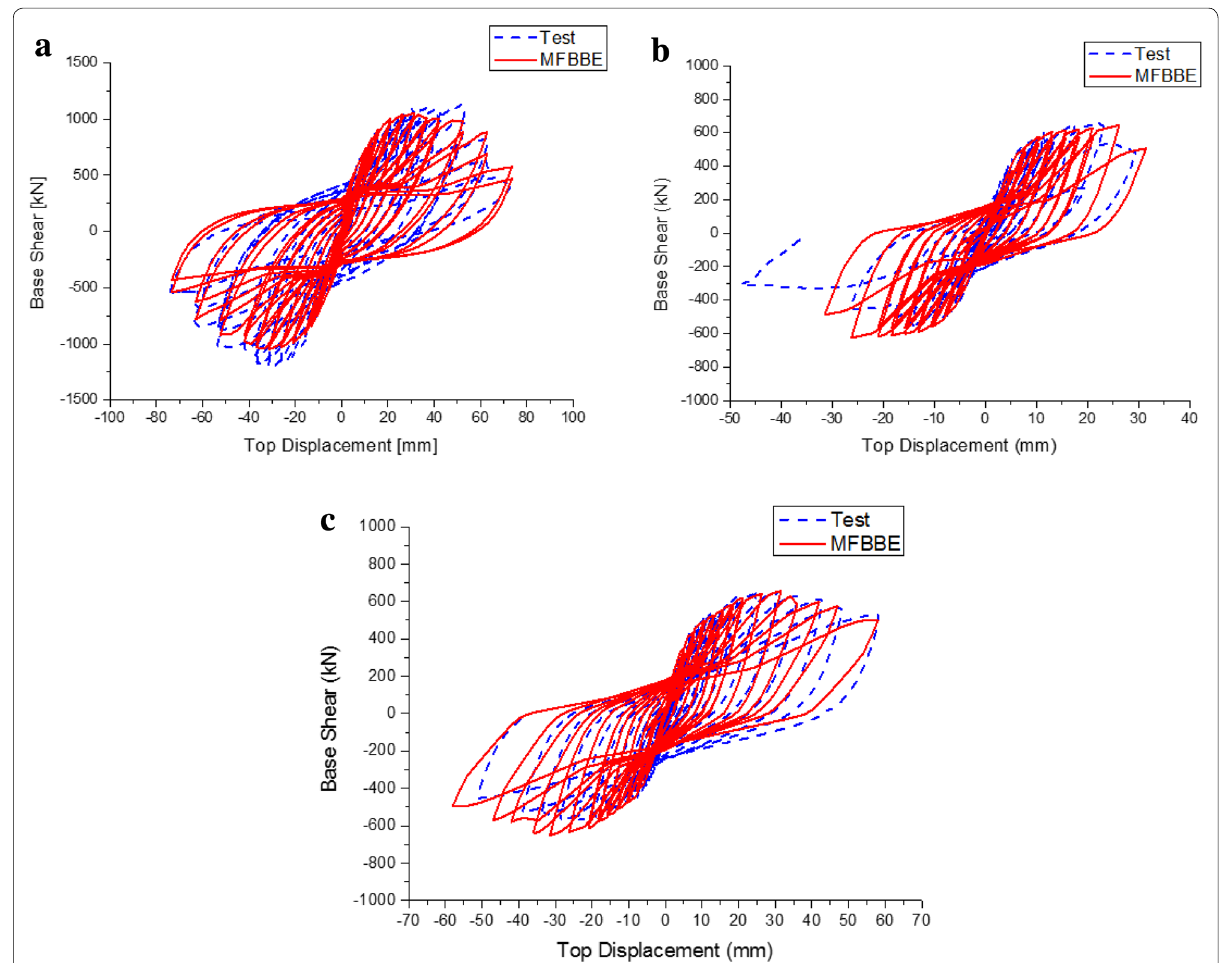
Fig. 9 Comparison of the hysteretic curves of a BD-2.0, b CB-1, c CB-2 using Mander confined concrete model and proposed shear